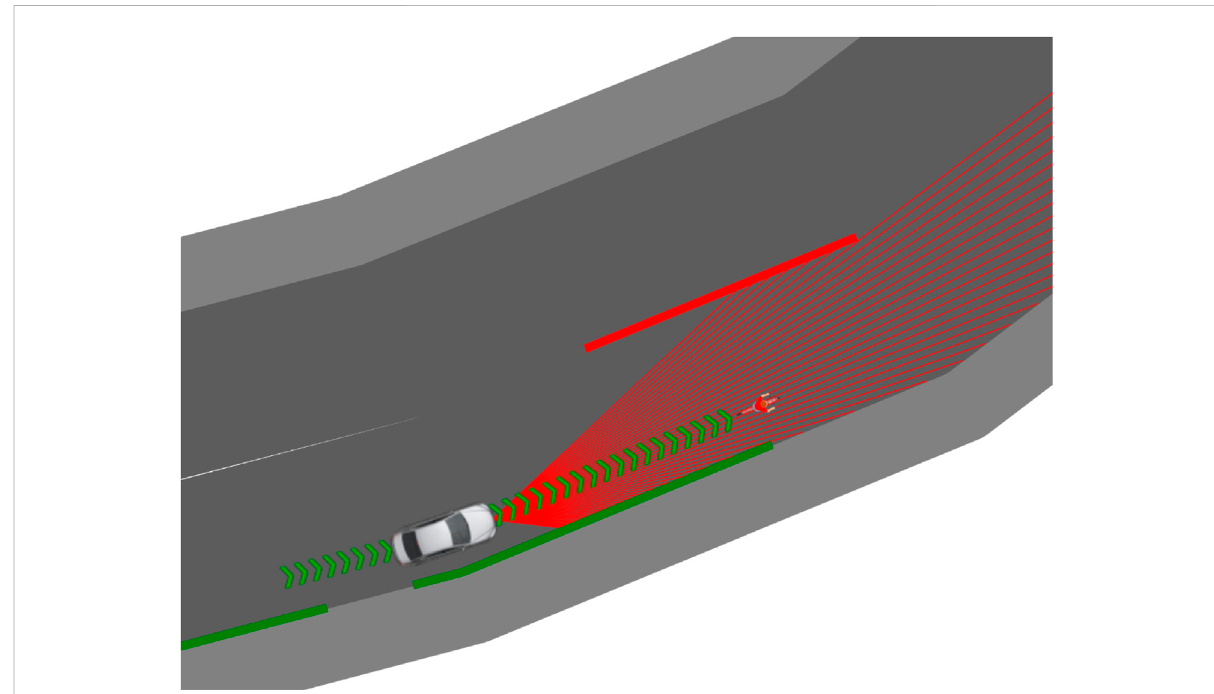
FIGURE 4 The visualisation of the sensor working principle including the projected trajectory. The thin red lines represent the LiDAR ’ s recognition rays, with the thick red and green lines showing the derived left and right lane border and, ultimately, the proposed driving path given by the green